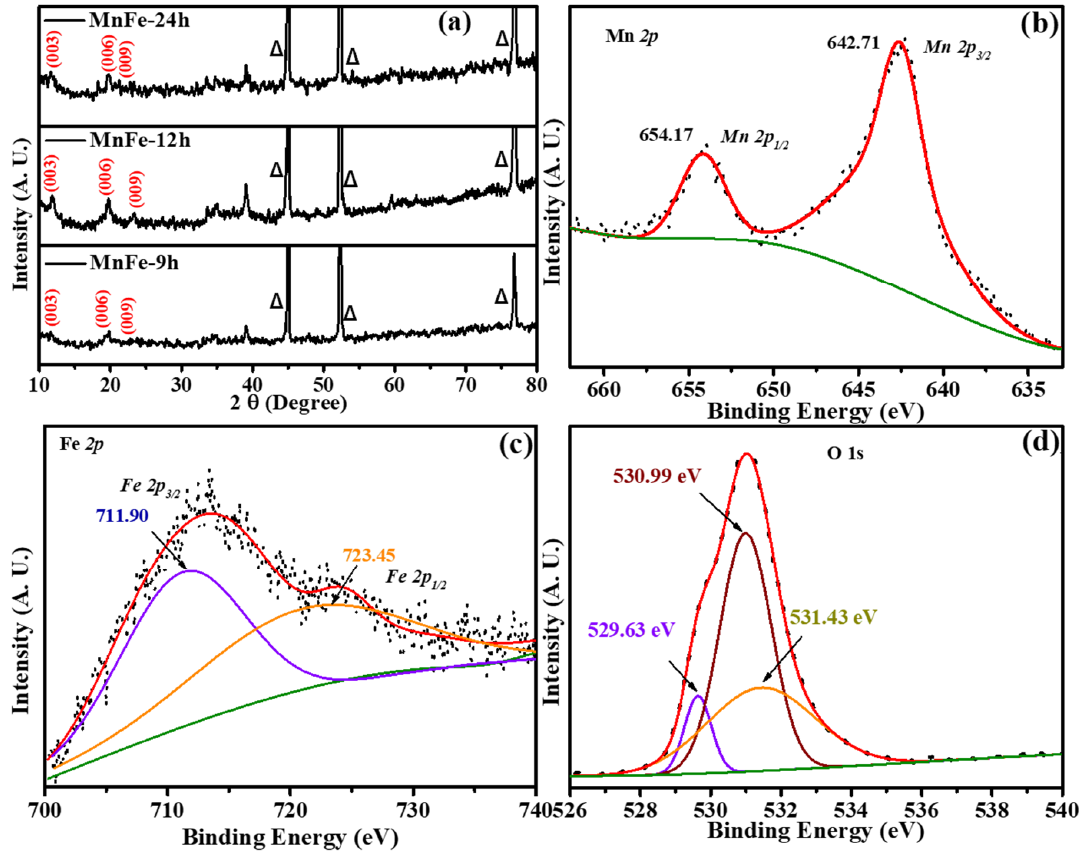
Figure 4. ( a ) XRD patterns of MnFe-9h, MnFe-12h, and MnFe-24h. High resolution spectra of MnFe-12, ( b ) Mn 2p, ( c ) Fe 2p, and ( d ) O 1s.